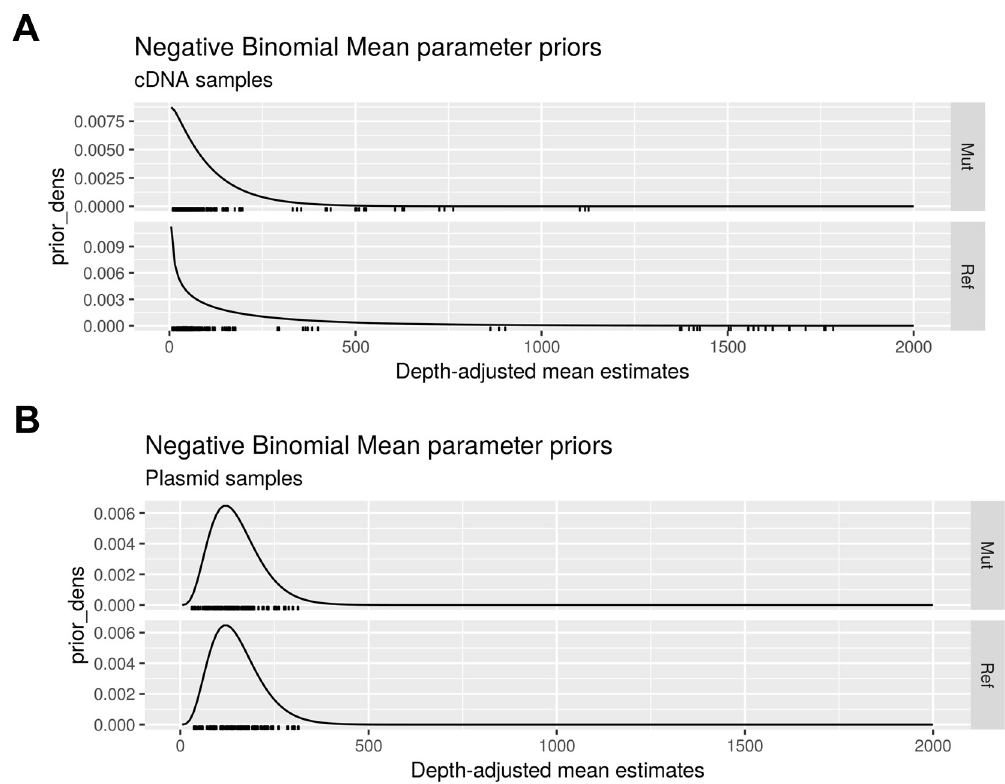
Fig 8. Negative binomial mean parameter priors. Density functions of the empirically estimated gamma priors for (A) the cDNA samples and (B) the plasmid library samples.